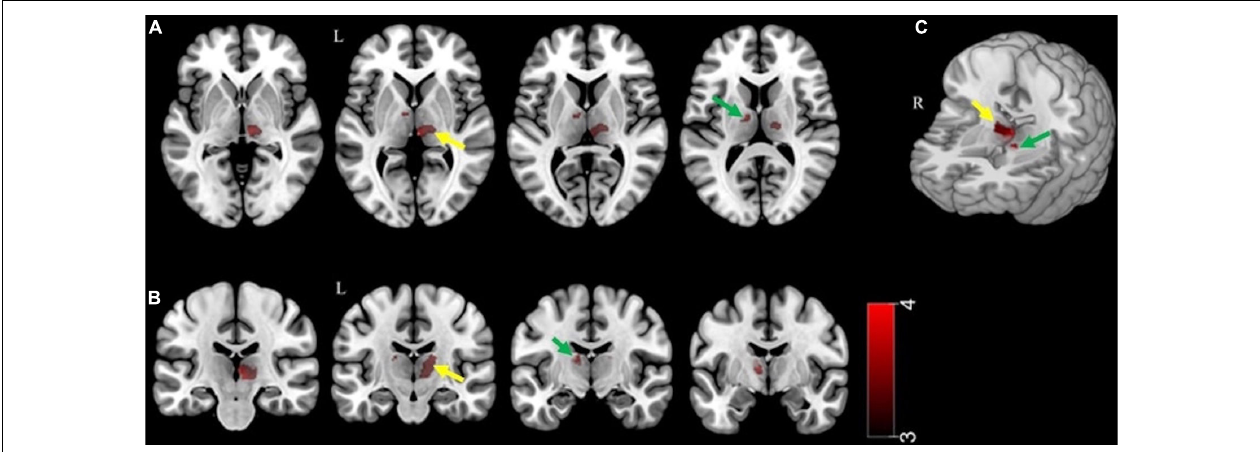
FIGURE 1 | Thalamic areas showing increased gray matter volume in NK refugees compared with SK residents. Thalamic areas showing increased gray matter volume in NK refugees, compared with SK residents, are shown in the (A) axial plane, (B) coronal plane, and (C) 3D rendering. These areas correspond to the left medial nuclei (green arrow) and right medial-posterior nuclei (yellow arrow). The voxel-wise uncorrected statistical threshold was set at p < 0.001, and the cluster-wise familywise error rate-corrected threshold at p < 0.05, with small volume correction. NK, North Korean; SK, South